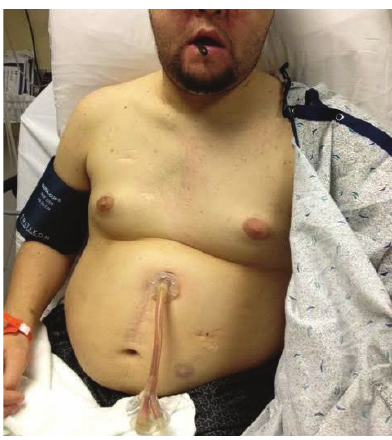
Figure 1: Patient with the tip of the G-J tube protruding from his mouth.